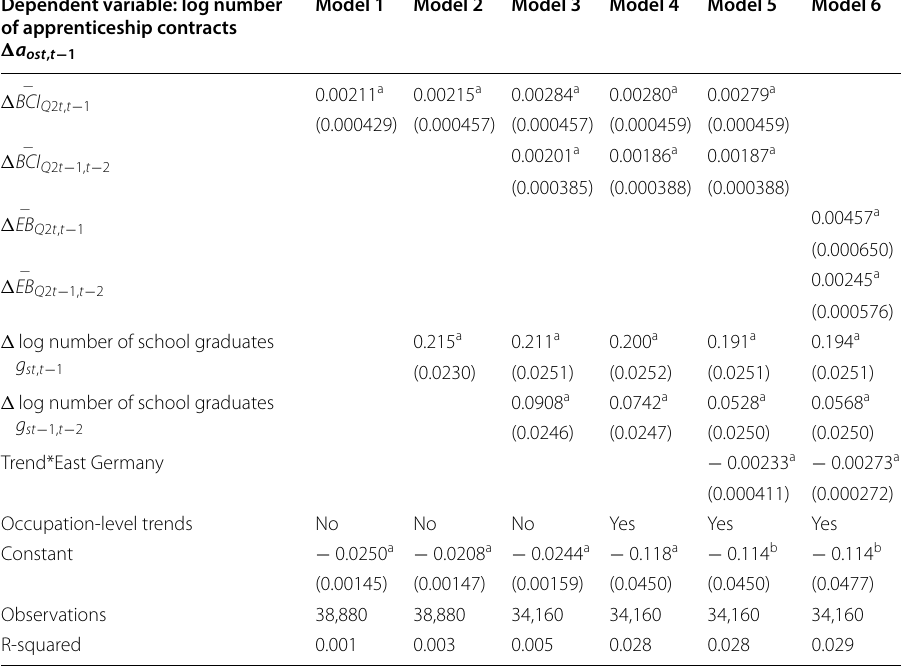
Heteroskedasticity and autocorrelation‑robust standard errors in parentheses. a Significant at the 1%‑level; b significant at the 5%‑level; c significant at the 10%‑level. Data sources: Vocational training statistics of the statistical offices of the federal and state governments, ifo Business Climate Index (BCI), ifo Employment Barometer